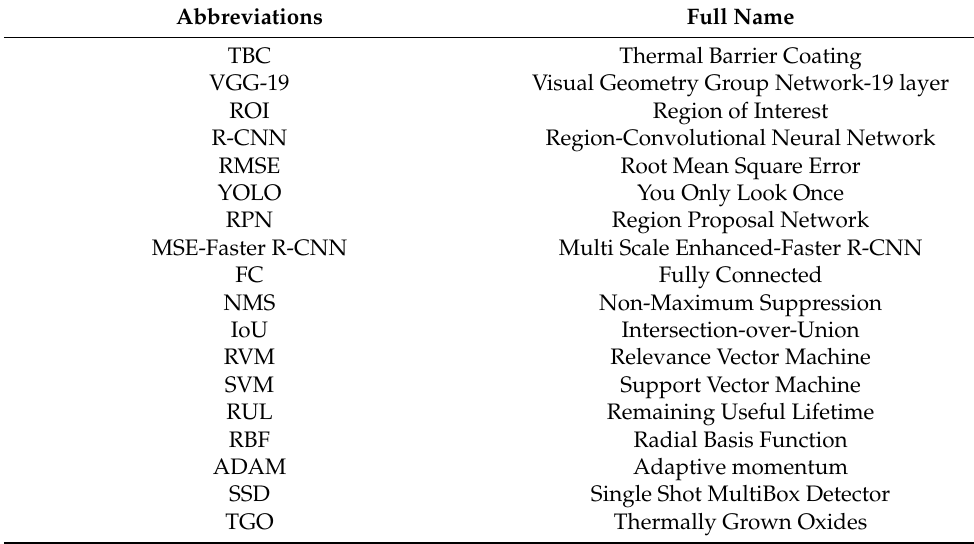
Table A1. The list of